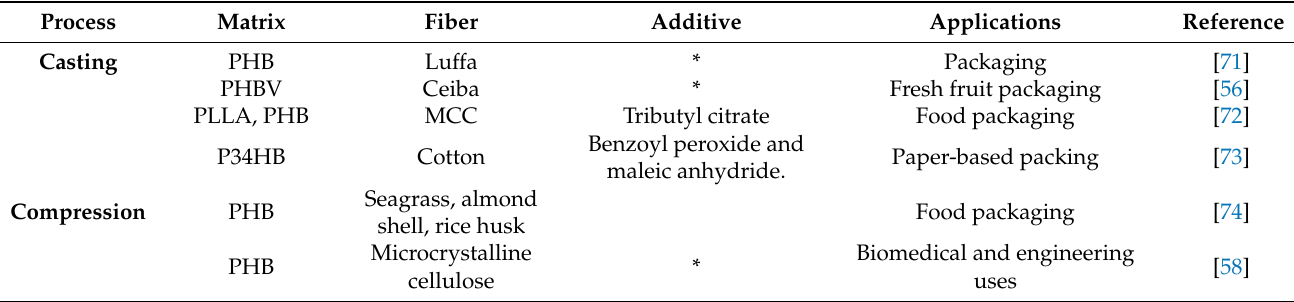
Table 2. Common methods to produce biodegradable